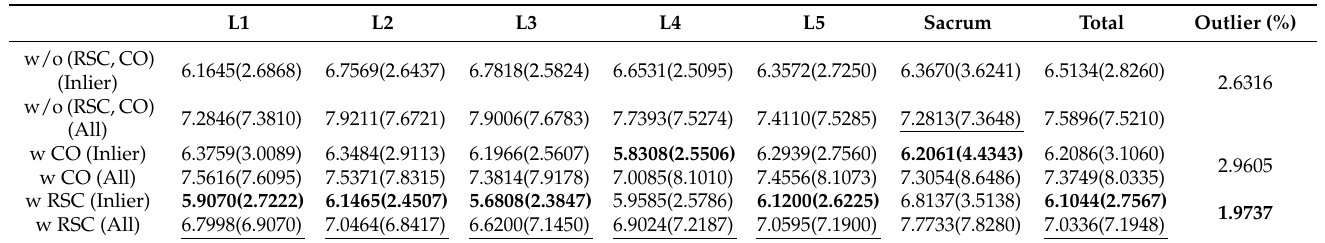
Table 4. Ablation study of the conventional cutout (CO) and random spine cutout (RSC). The value having the lowest distance error for each column in (Inlier) is marked in bold and underlined for (All). L1 L2 L3 L4 L5 Sacrum Total